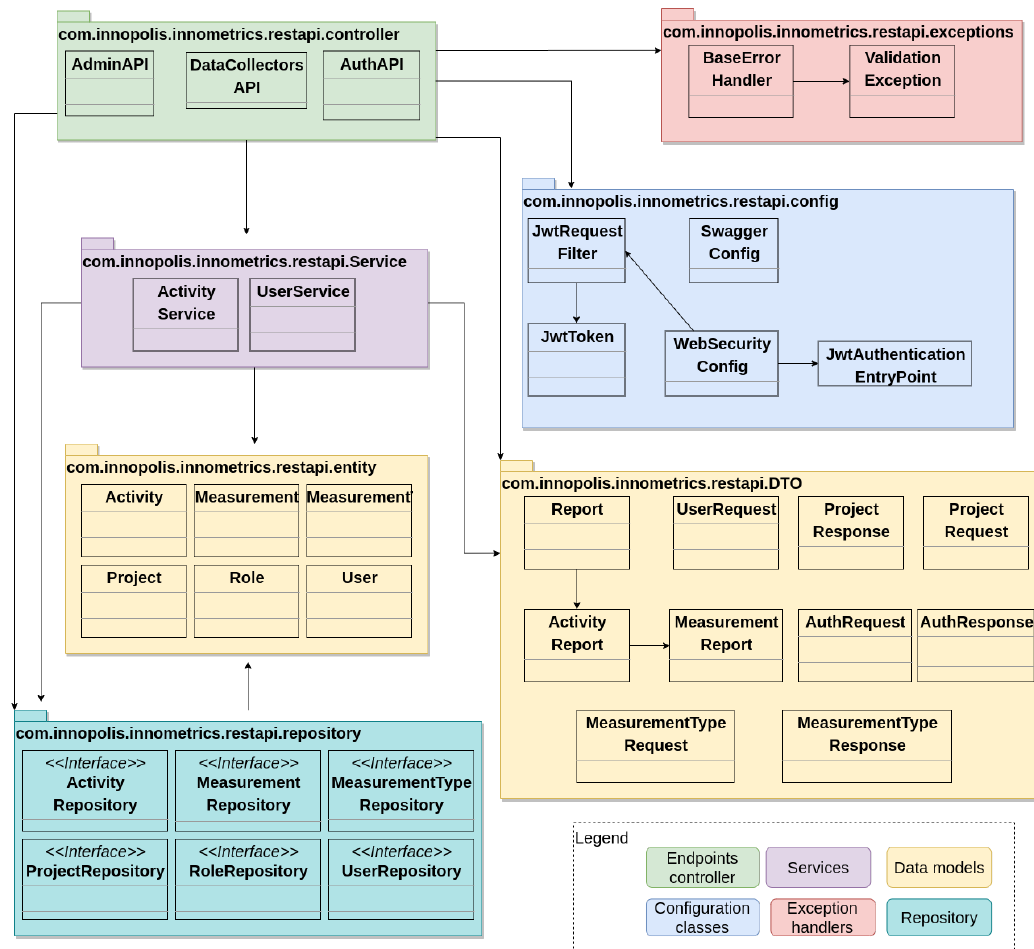
Figure 3. Technical architecture of data collector